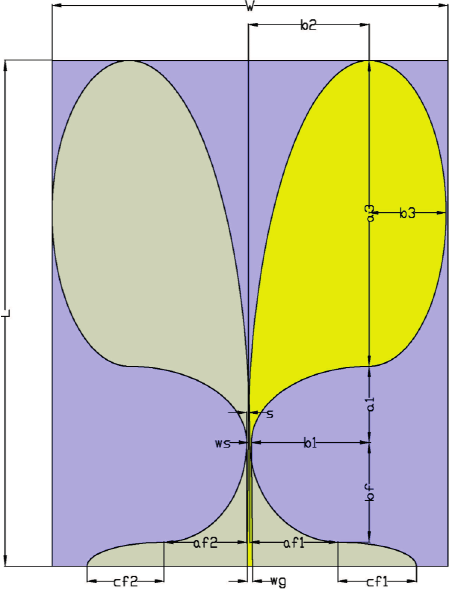
Figure 2. Antipodal Vivaldi